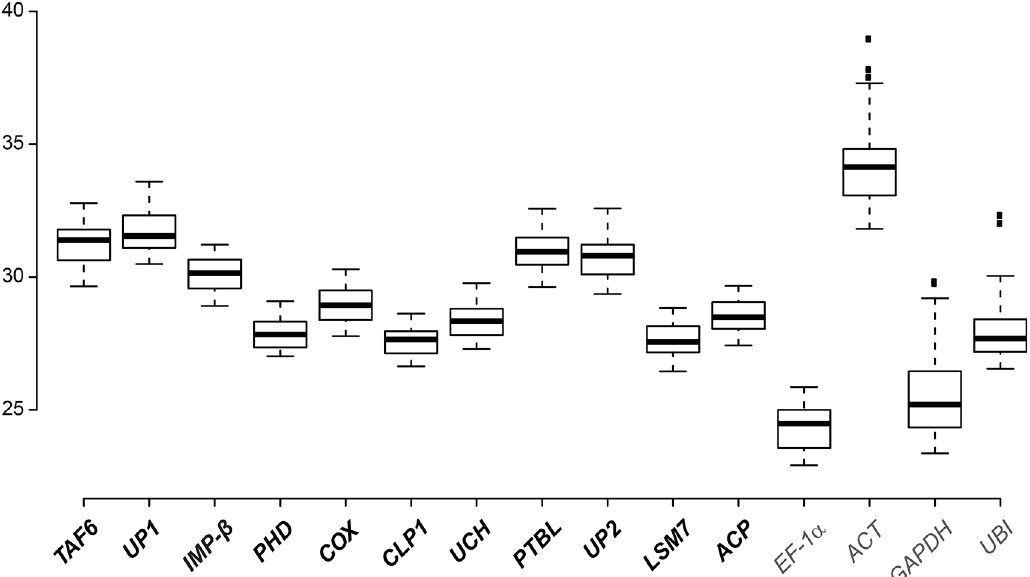
Fig 2. Expression profiles of new candidate reference genes and classical housekeeping genes from tomato. Box plot graphs of Ct values for each reference gene tested in all samples (n = 48). Ct values are inversely proportional to the amount of template. Boxes indicate the 25/75 percentiles, median values are represented by black lines. Whisker caps indicate the value range, dots represent outliers. New reference gene candidates are indicated in